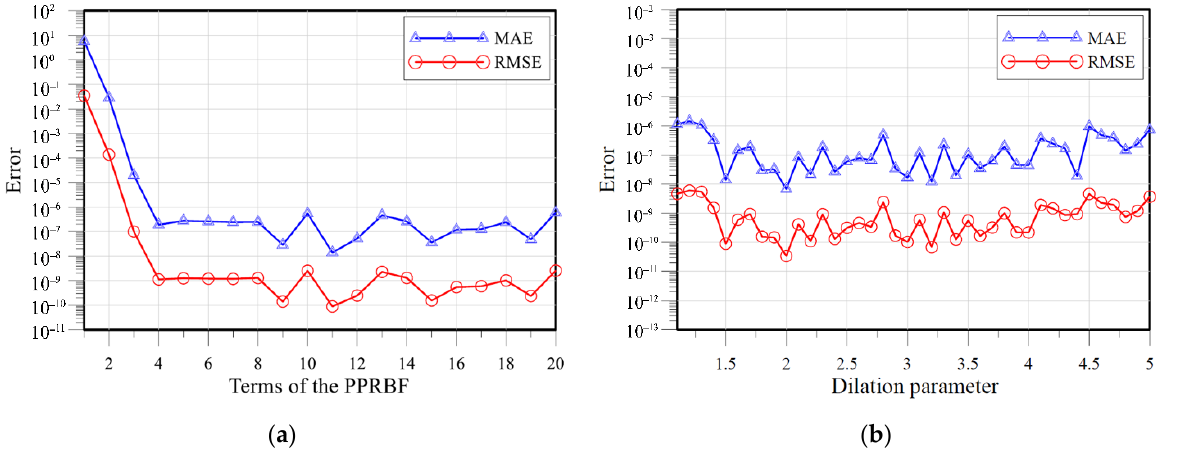
Figure 18. Error versus the terms of the PPs and dilation parameter: ( a ) Error versus the terms of the PPs and ( b ) Error versus the dilation parameter. Table 3. Errors of the proposed method with various noise levels.